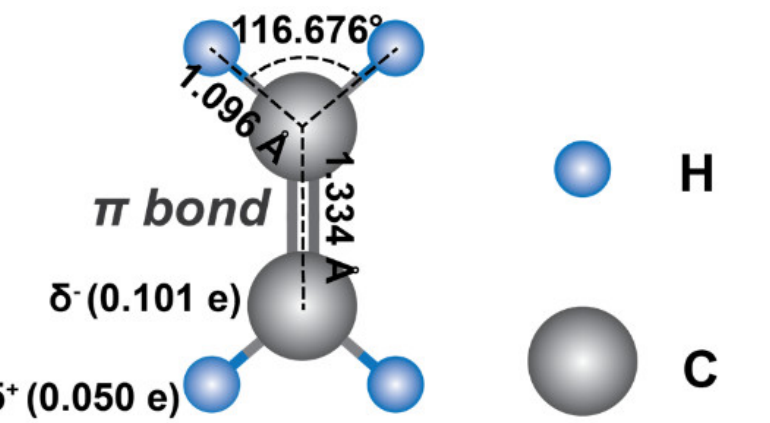
Figure 1. The molecular structure of ethylene.